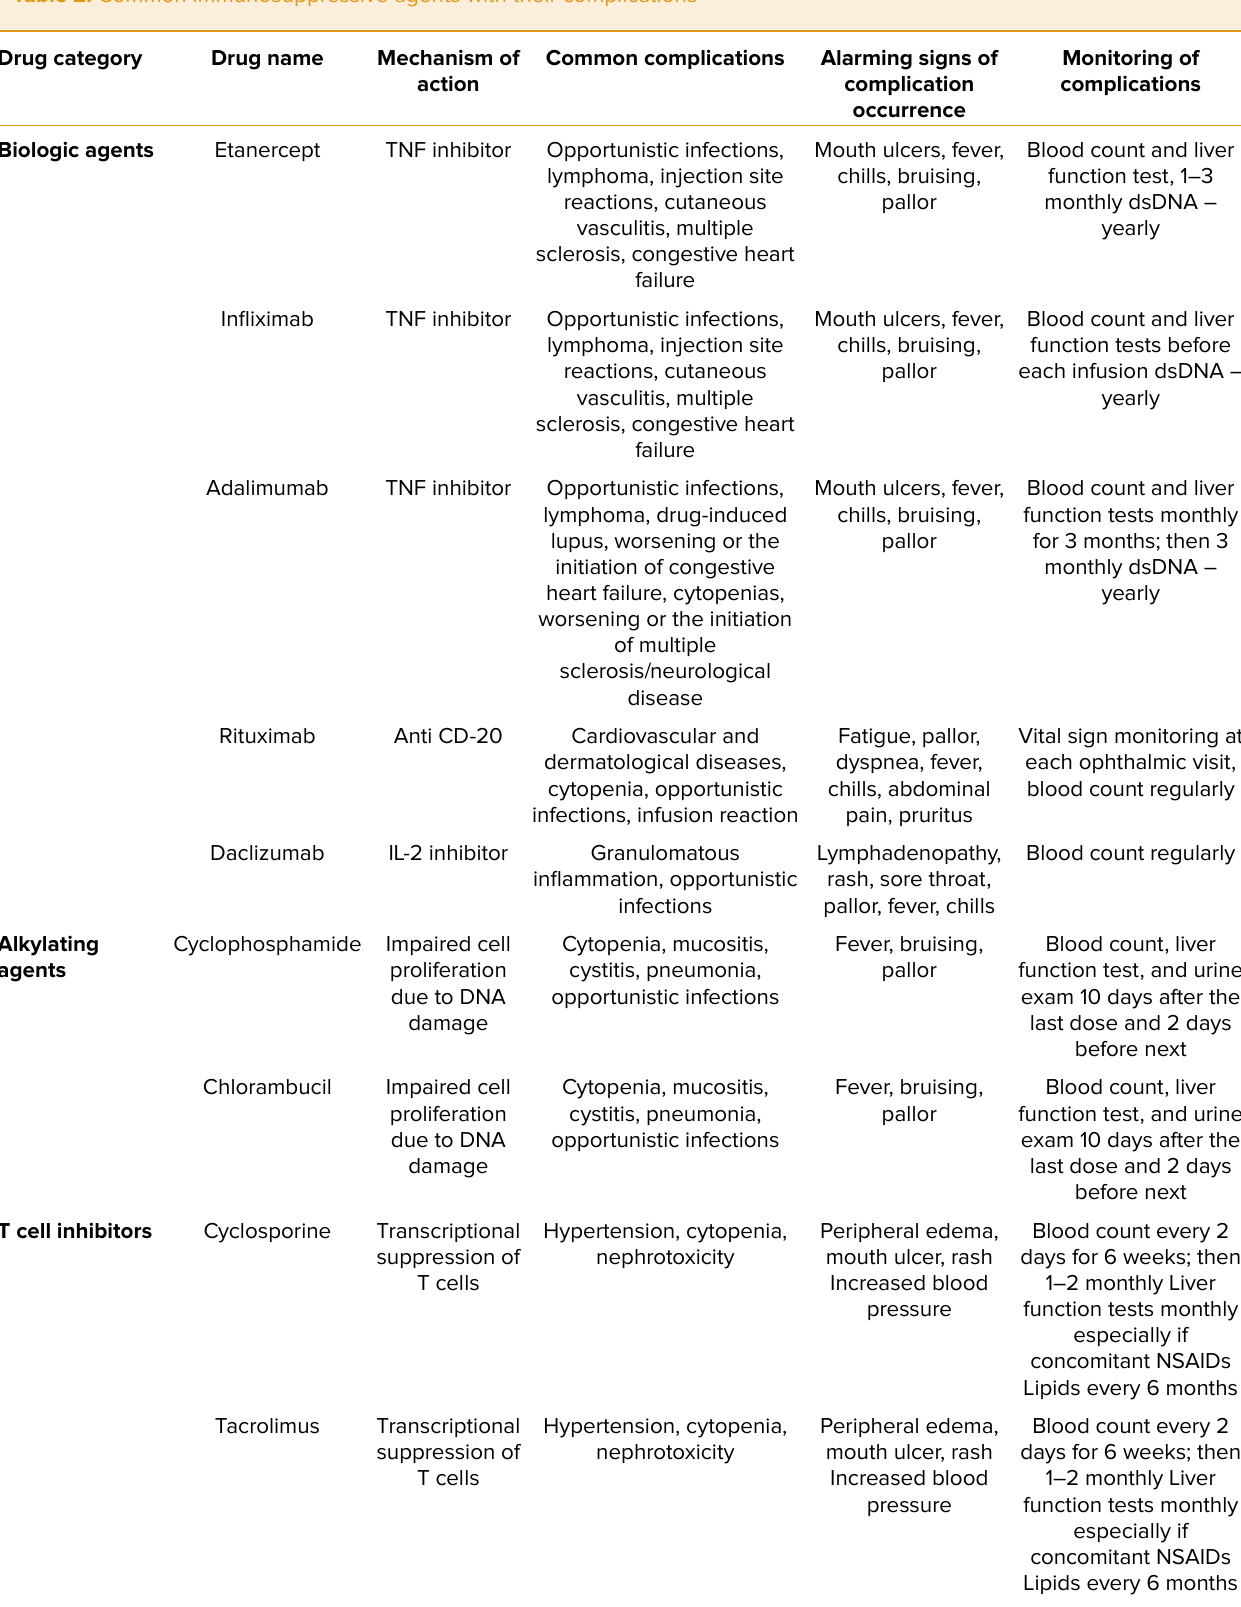
Table 2. Common immunosuppressive agents with their